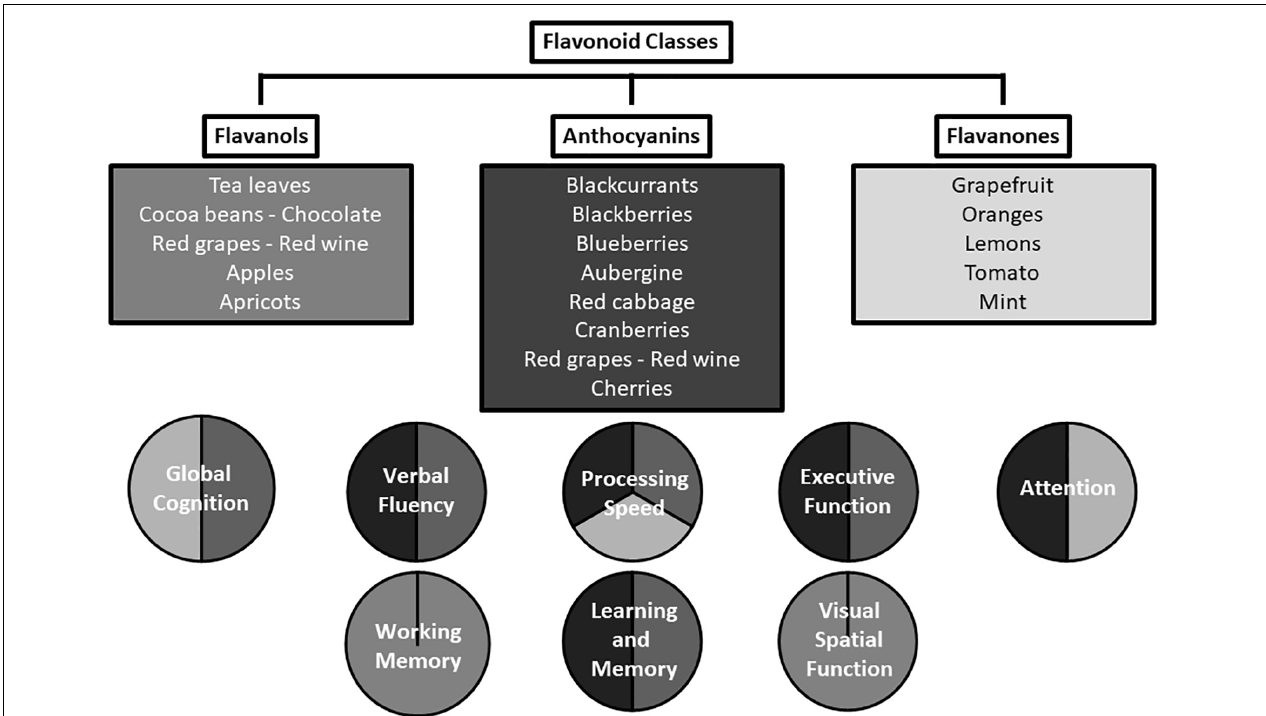
FIGURE 2 | Cognitive domains affected by the flavonoid subclasses of anthocyanins, flavanols, and flavanones.